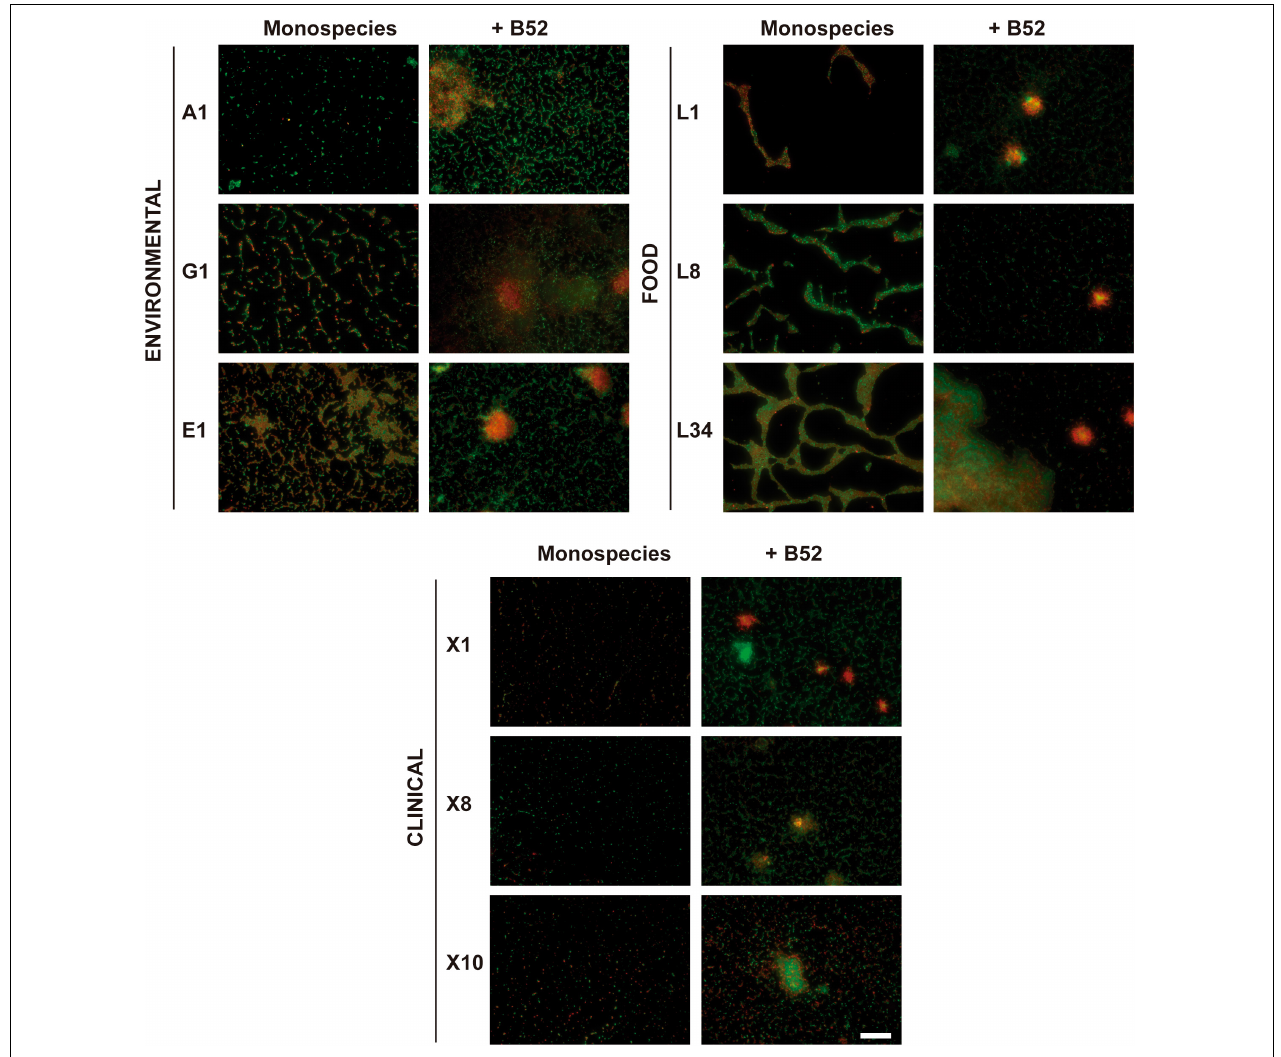
FIGURE 1 | Influence of the accompanying strain. Representative 40 × -field fluorescence micrographs after LIVE/DEAD staining of different L. monocytogenes 48-h-old biofilm cultured either in monospecies or dual-species with P fluorescens B52 on AISI 316 SS coupons. Scale bar, 50 µ